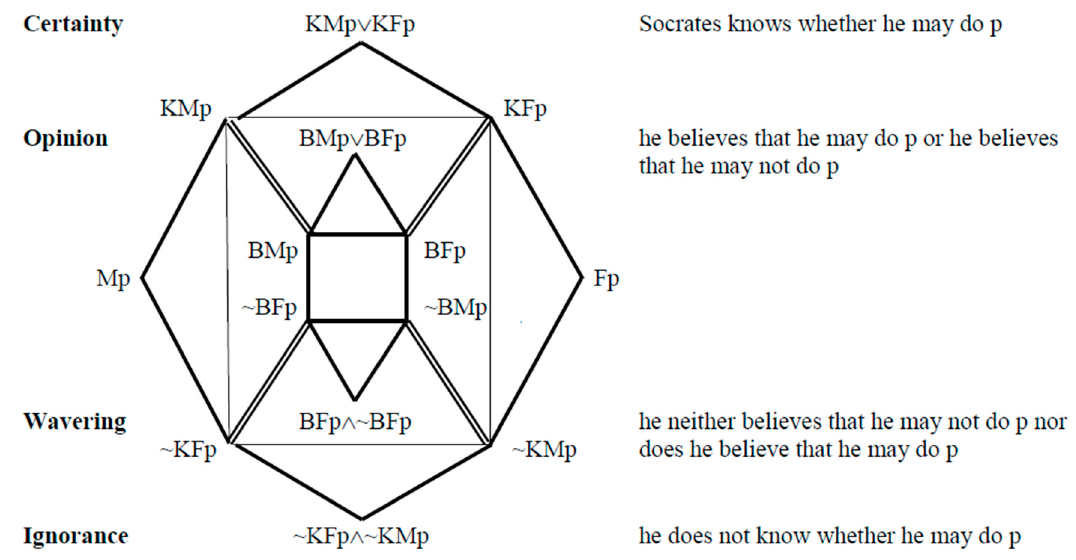
Figure 14. Epistemic, doxastic, and deontic logics combined.